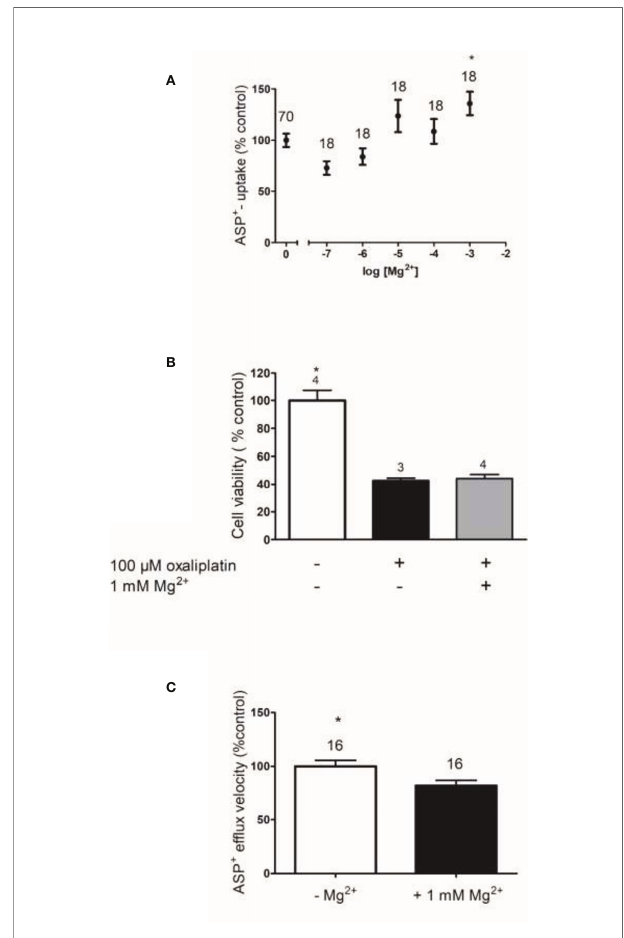
FIGURE 1 | The effects of Mg 2+ on hOCT2 function (A) , on hOCT2-mediated Oxaliplatin toxicity (B) , and on hMATE1 function (C) . Function of the transporters was measured as uptake (hOCT2) or ef fl ux (hMATE1) of the fl uorescent organic cation 4-[4-(dimethylamino)styryl]-N-methylpyridinium (ASP + ) as described in Wilde et al. (56) and Kantauskaite et al. (57) Panel (A) shows the changes of ASP + uptake by hOCT2 stably expressed in Human Embryonic Kidney (HEK) cells in dependence from extracellular Mg 2+ concentration compared to what was measured in Mg 2+ absence (mean ± SEM). Only 1 mM Mg 2+ signi fi cantly increased ASP + uptake by hOCT2 (Kruskal – Wallis test with Dunn ’ s multiple comparison test). The presence of Mg 2+ stimulates the activity of hOCT2, a transporter mediating nephrotoxicity of platinum derivatives, therefore regulation of hOCT2 by Mg 2+ cannot explain Mg 2+ protective effects against cisplatin nephrotoxicity. (B) shows the effects of Mg 2+ supplementation (1 mM) on toxicity of 100 µM Oxaliplatin measured with a 3-(4,5-dimethylthiazol-2-yl)-2,5-diphenyltetrazolium bromide (MTT) assay in hOCT2 overexpressing HEK cells (mean ± SEM). The presence of 1 mM Mg 2+ does not protect the cells against hOCT2-mediated Oxaliplatin toxicity. Finally, (C) shows the changes of ASP + ef fl ux by hMATE1 stably expressed in HEK cells in dependence from extracellular Mg 2+ concentration compared to what measured in Mg 2+ absence (mean ± SEM). The extracellular presence of 1 mM Mg 2+ slightly but signi fi cantly decreases the function of hMATE1 (Mann – Whitney-test), which is an ef fl ux transporter for platinum derivatives. Therefore, also a regulation of hMATE1 by Mg 2+ cannot explain Mg 2+ protective effects against cisplatin nephrotoxicity. In (A, C) the numbers above the columns represent the number of replicates measured in at least three independent experiments. In (B) they represent the number of independent